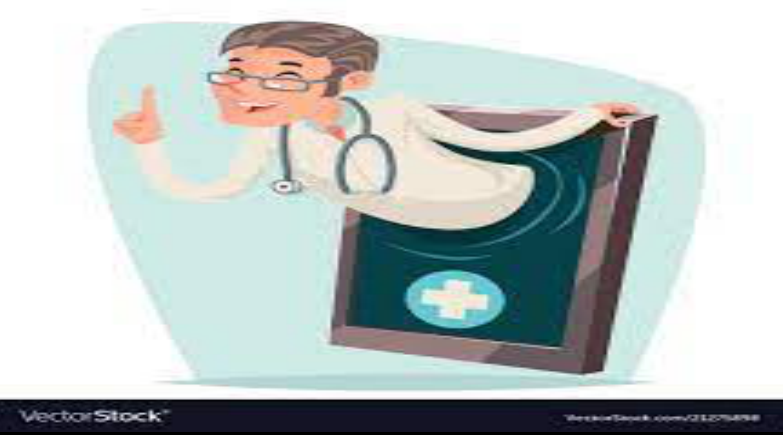
Fig. 1. Effective mobile treatment